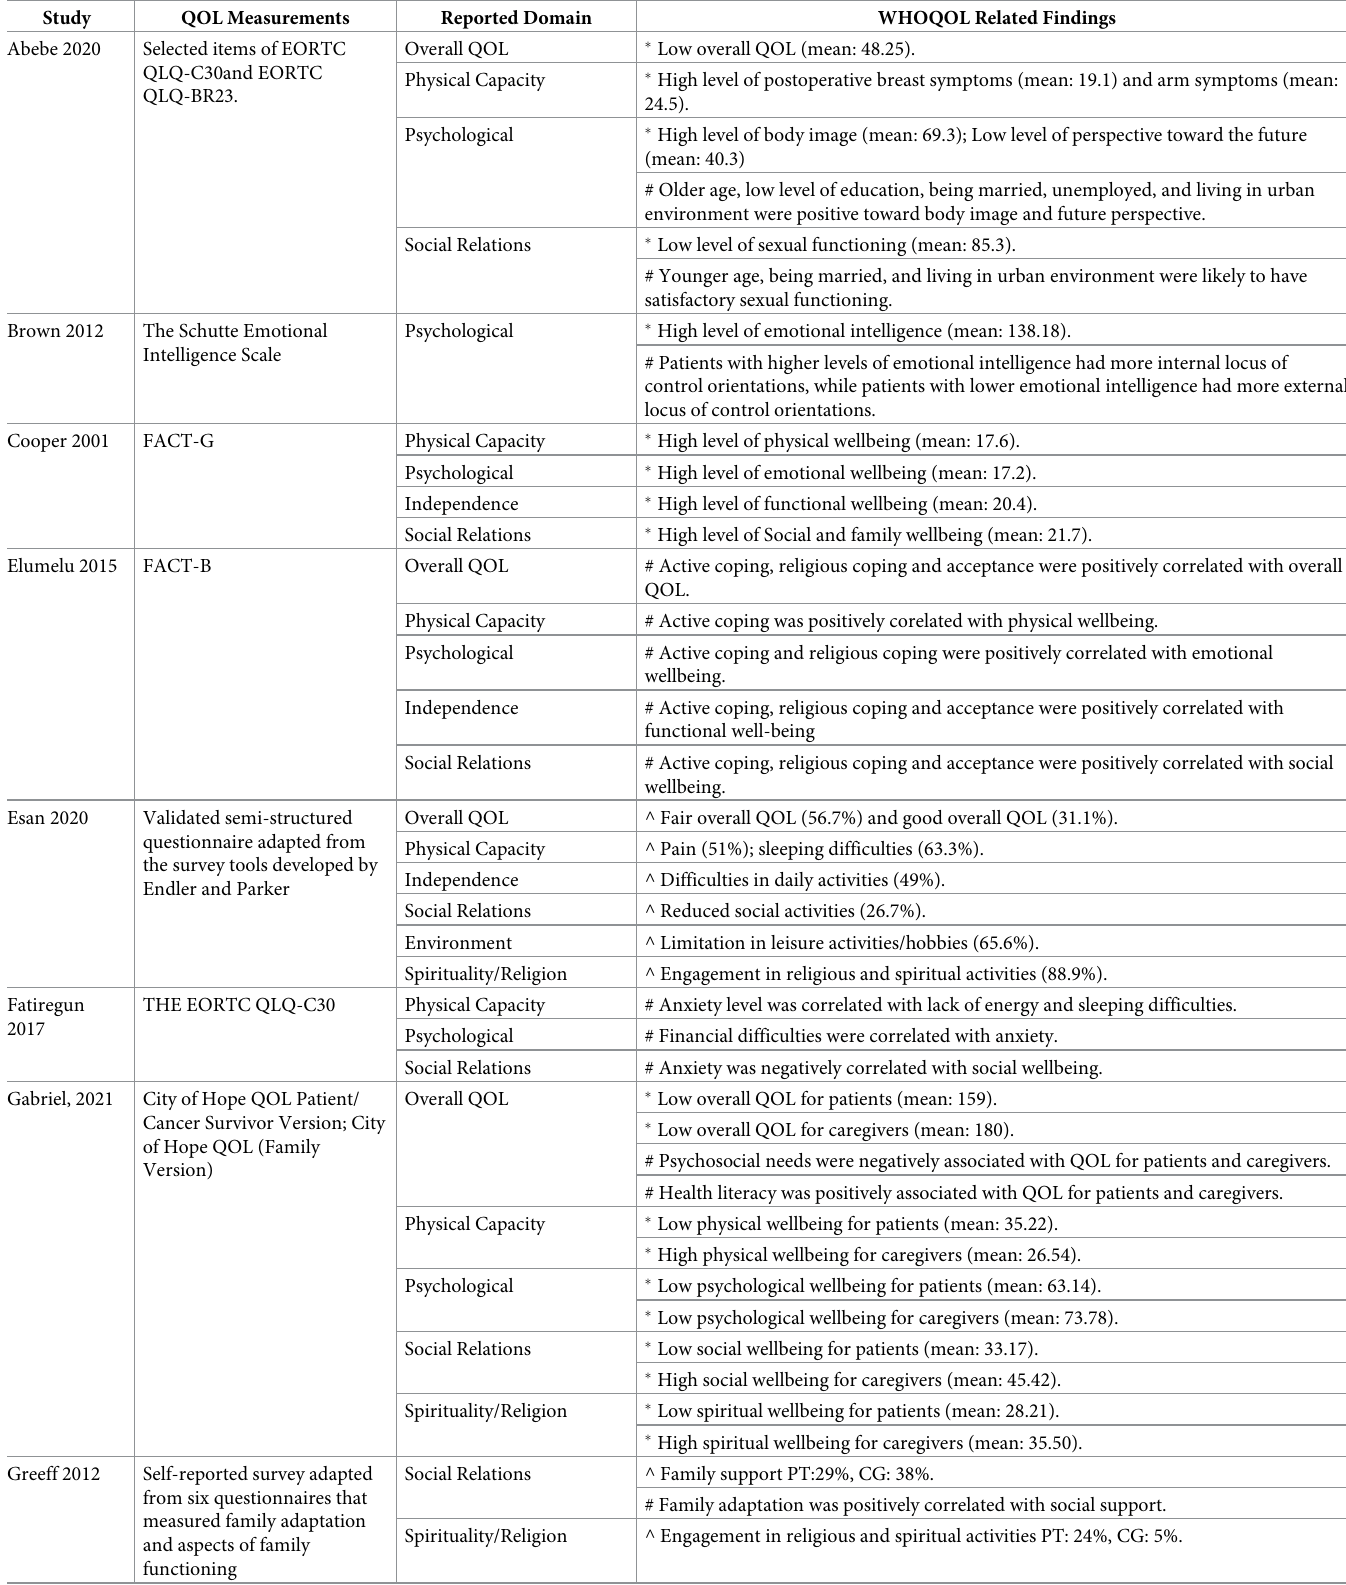
Table 3. WHOQOL related